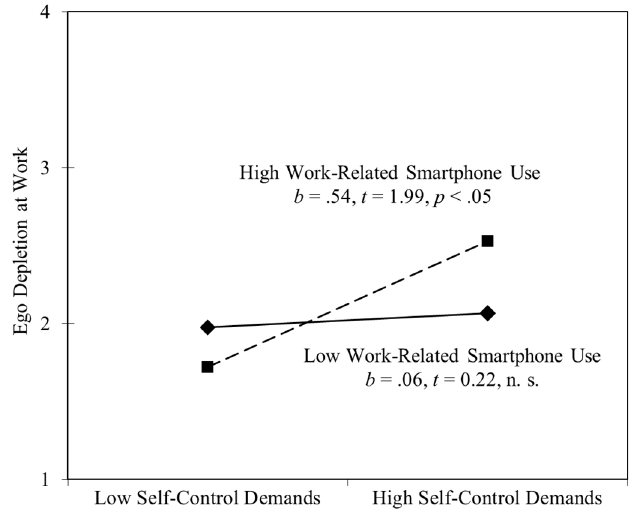
Figure 2. Two-way interaction of work-related smartphone use and next-day self-control demands on next-day ego depletion at work. High and low values were operationalized by one standard deviation above and below the mean.